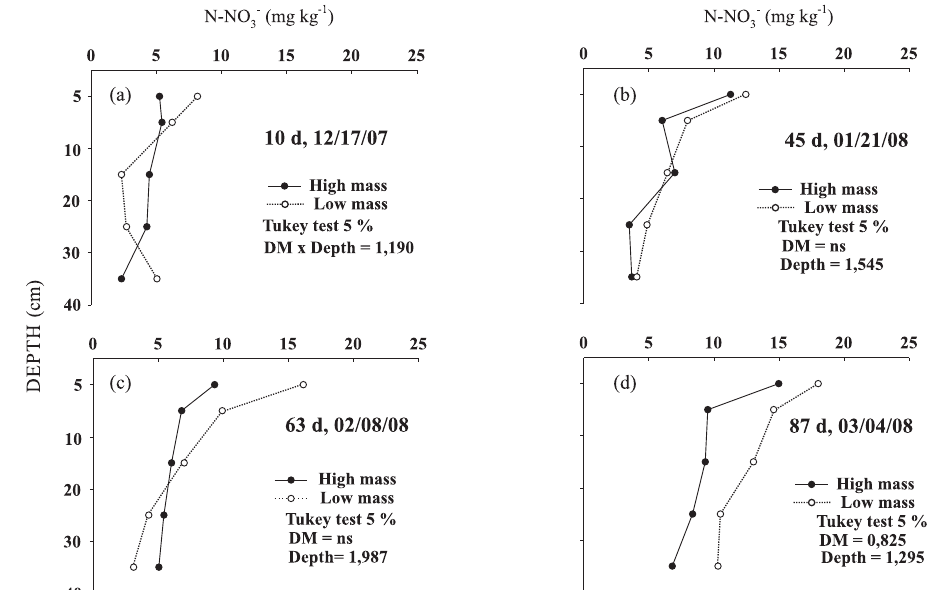
Figure 3. Soil N-NO 3- levels in relation to different forage mass (HM = 3,600 kg ha -1 of DM and LM = 2,000 kg ha -1 of DM) in the soil profile (depth 40 cm) under Alexandergrass ( Brachiaria plantaginea